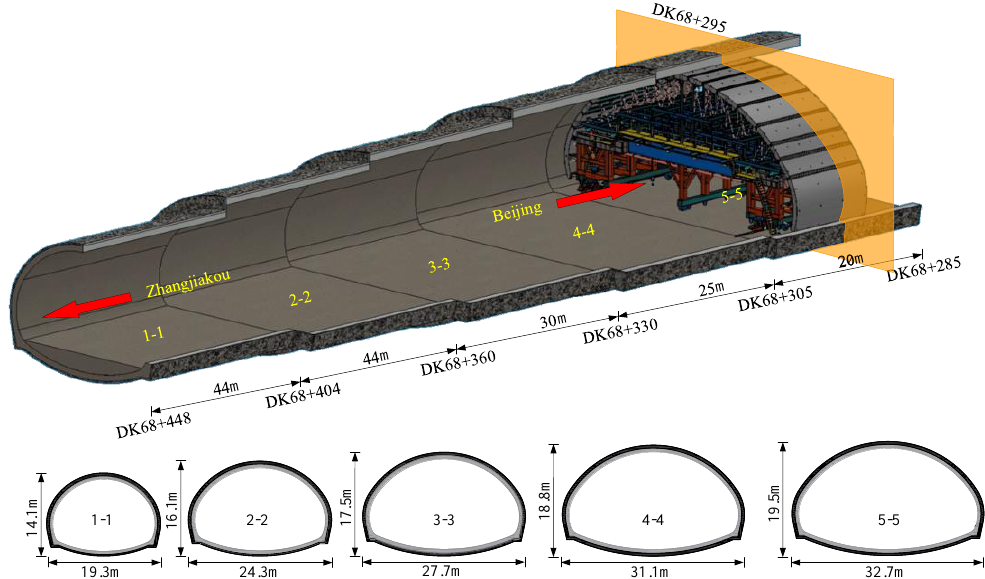
Figure 3. The layout and cross section of the super–span tunnel.